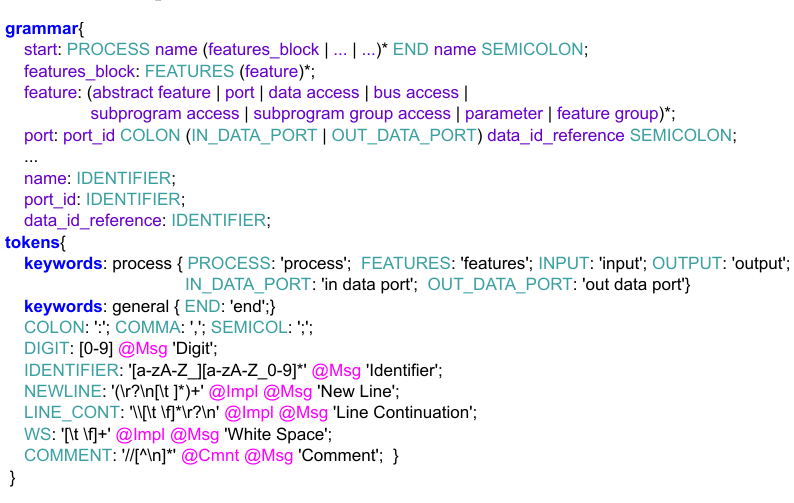
Figure 2. Excerpt of the SCCD model that defines the behavior of the editor.